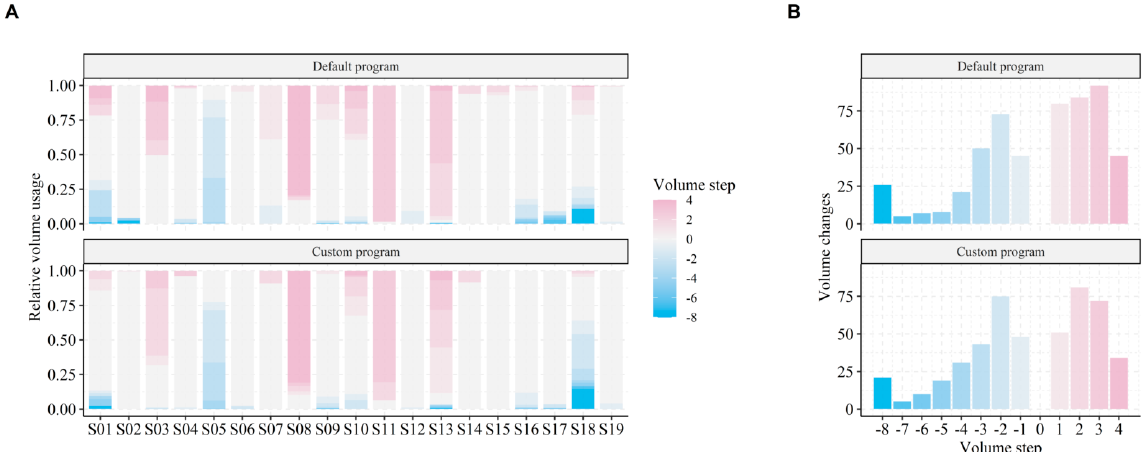
Figure 5. Volume level usage and level changes. ( A ) Relative volume usage for each listening program (panels) and each subject. ( B ) Number of volume changes made to each volume step across all subjects. The default volume (0) was activated on each device reset and program change. Thus, all changes to level 0 were not considered.